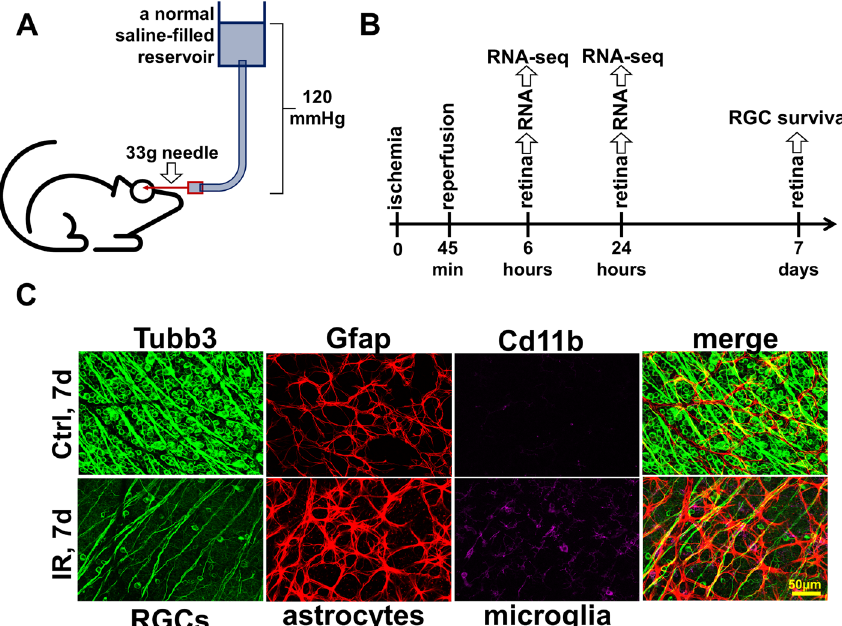
Figure 1. Ischemia–reperfusion (IR) leads to significant retinal damage. ( A ) Transient retinal ischemia was induced for 45 min by increasing intraocular pressure (IOP, 120 mm Hg). ( B ) Ischemic and normotensive retinas collected 6 and 24 h after reperfusion were used for RNA-seq analysis. Retinas collected 7 days after reperfusion were used to study RGC survival. ( C ) The representative confocal images indicate significant RGC death (Tubb3 as a marker) and reactive gliosis (Gfap and Cd11b as markers) in ischemic retinas 7 days after